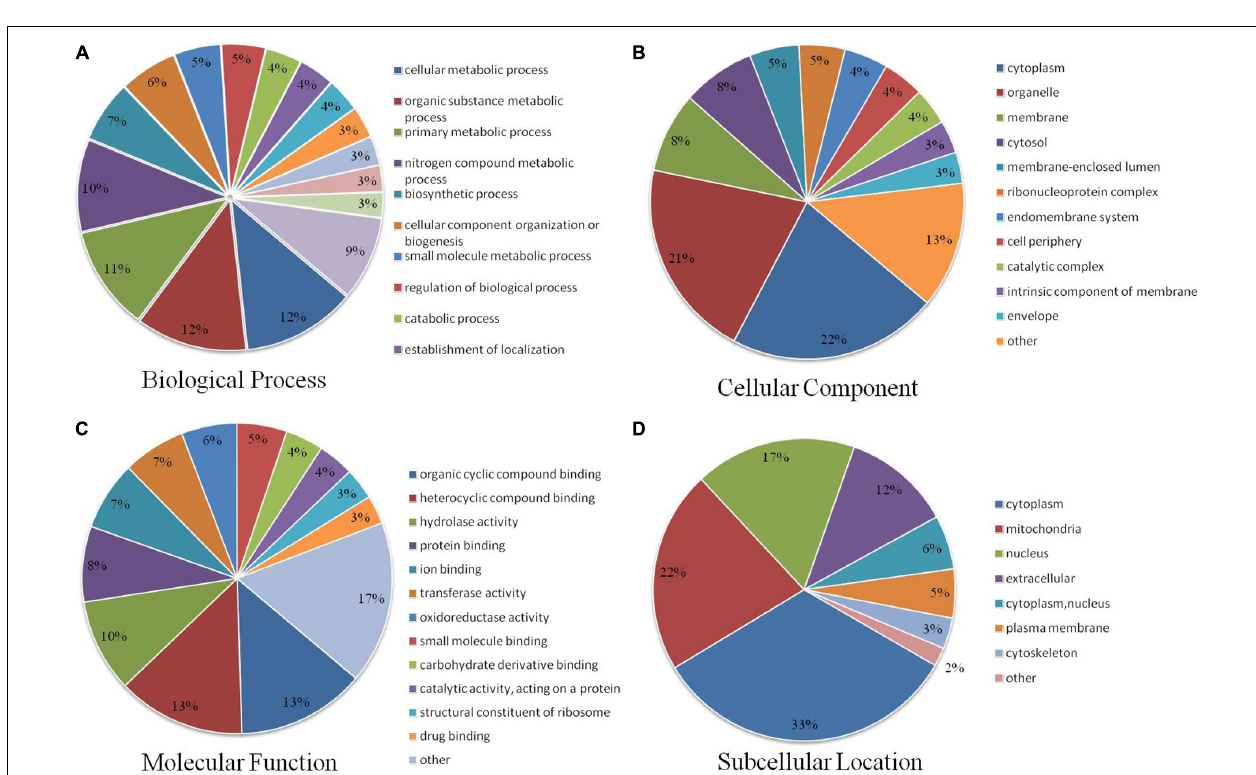
FIGURE 3 | Pie charts showing the distribution of Khib proteins. (A) Khib proteins categorized according to biological process. (B) Cellular component. (C) Molecular function. (D) Subcellular localization.